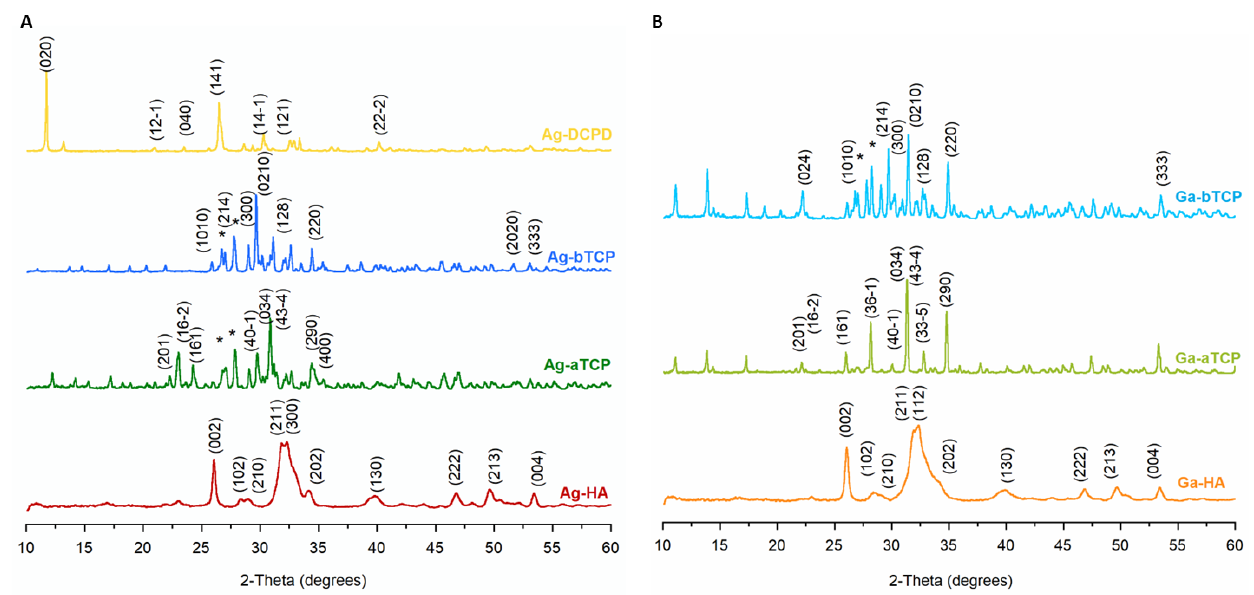
Figure 3. PXRD diffractograms of the obtained calcium phosphates: ( A ) enriched with silver ion, ( B ) enriched with gallium ion (*-calcium pyrophosphate).